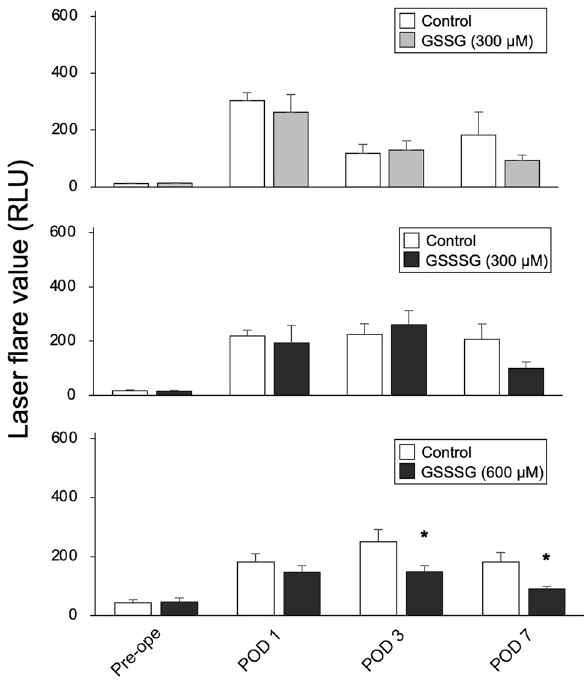
Figure 2. Effect of GSSSG on increased aqueous flare after cataract surgery. Time-course changes in aqueous flare in rabbit eyes before and after cataract surgery with irrigating solution containing GSSG (300 µM; top image), GSSSG (300 µM; middle image), or GSSSG (600 µM; bottom image). Error bars indicate standard error of the mean. *P < 0.05 (two-way repeated measures ANOVA; n = 4-9). RLU: relative light unit. Pre-ope: